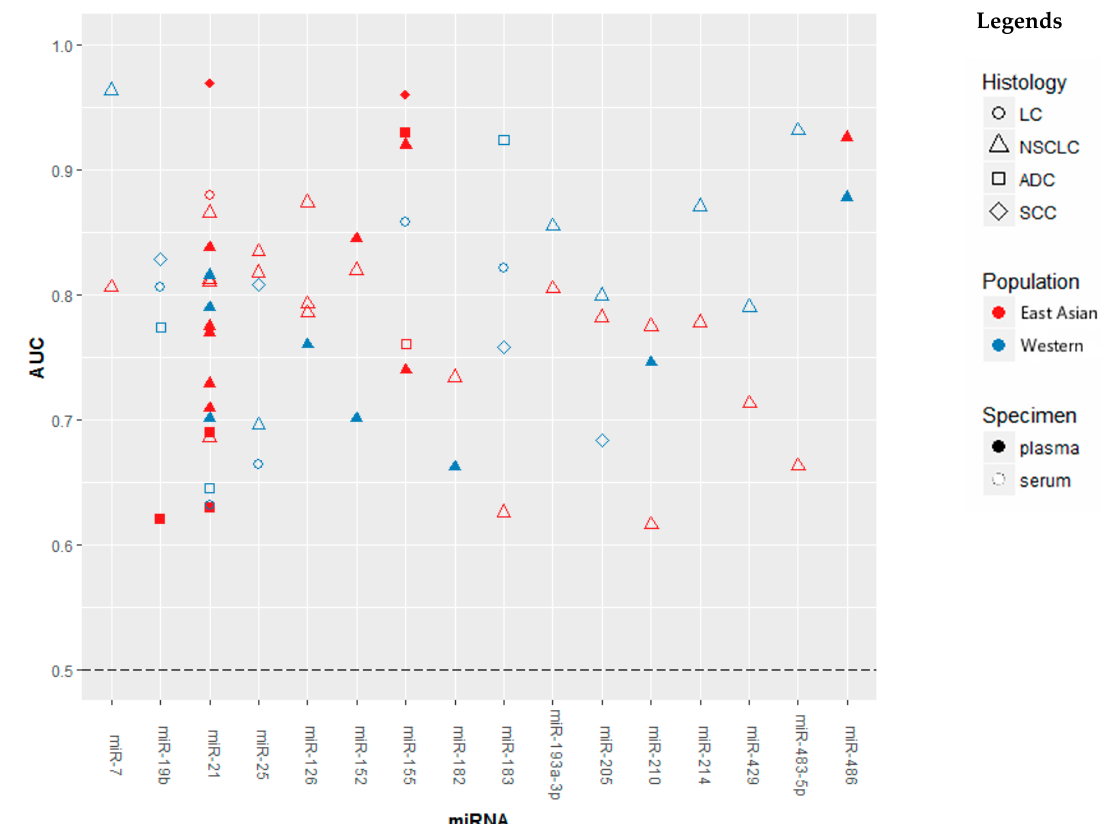
Figure 4. Graphical representation of Western studies versus East Asian studies of the diagnostic performance of miRNAs in lung cancer. Abbreviations: AUC: area under the curve; LC: lung cancer; NSCLC: non-small cell lung cancer; ADC: adenocarcinoma; SCC: squamous cell carcinoma.